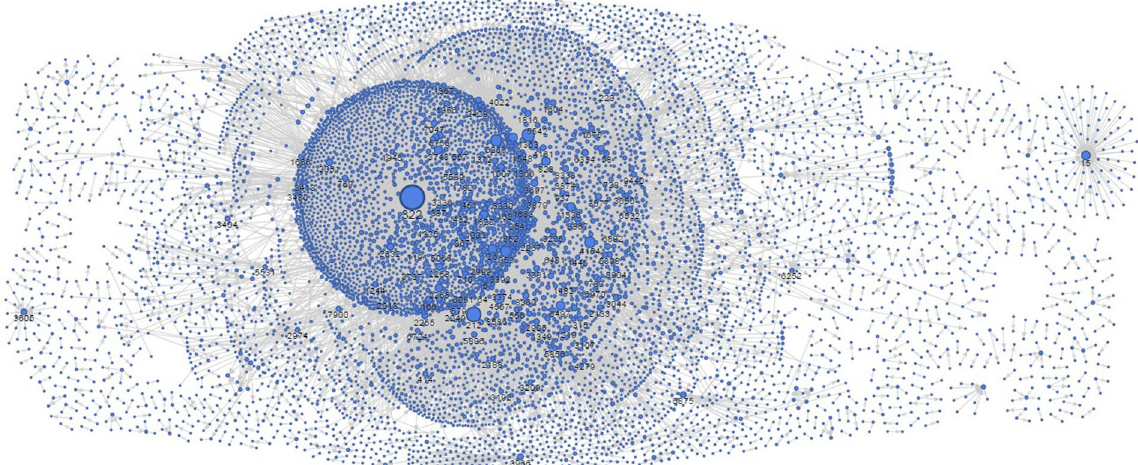
Figure 2. The HCN based on the Epinions trust network structure. Nodes represent worker agents and arrows represent trust relationships. The larger the size of a node, the more trusted a worker agent